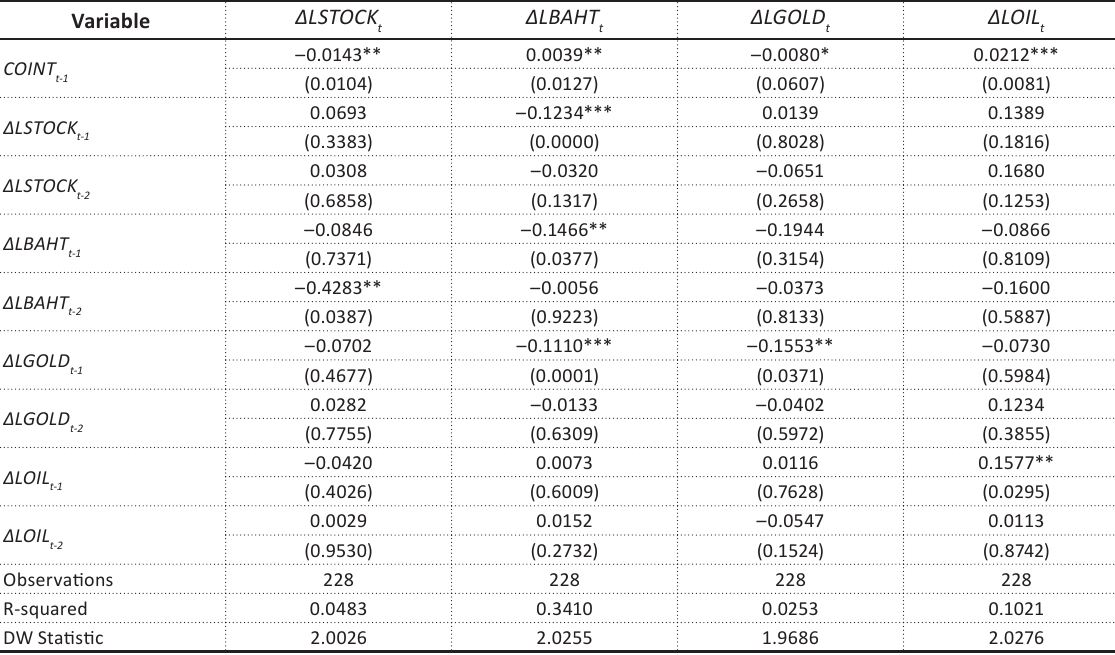
Table 5. Error correction mechanism